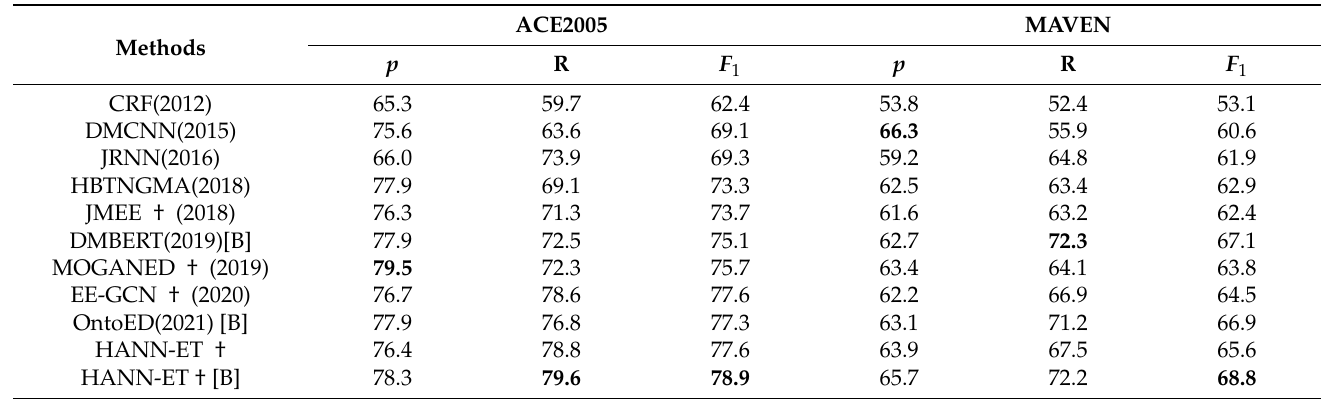
Table 3. Overall performance on two datasets in the case of predefined split (%).